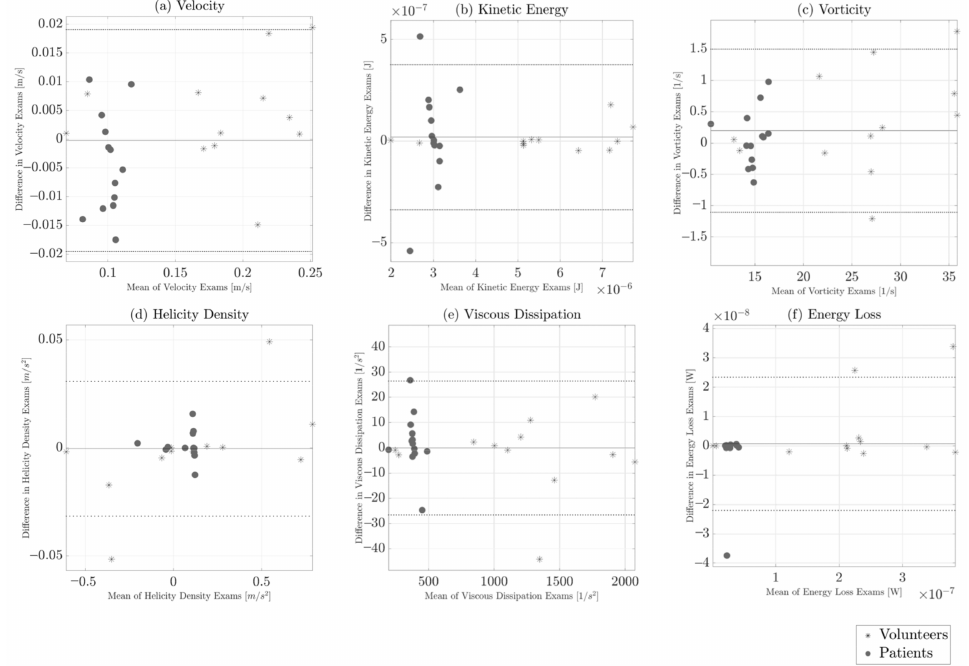
Figure A5. Bland-Altman plots represent the inter-observer reproducibility in the exams of LV global hemodynamic parameters ( a – f ) at e-wave. The thick line represents the mean difference, and the thin lines represent the limits agreement (1.96